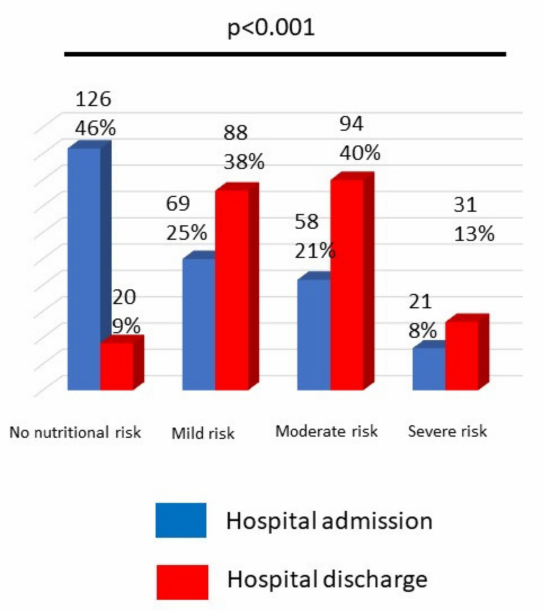
Figure 1. Changes in nutritional risk estimated by CONUT score. Bivariate CONUT score calculation was repeated with hospital discharge blood-test results. Patients with nutritional impairment at hospital discharge presented a higher incidence of paralytic ileus and urinary tract infection and a higher rate of readmission in intensive care units (ICU) (Table 5). Similarly to the previous analysis. when repeating the analysis using a logistic regression. variables maintained statistical